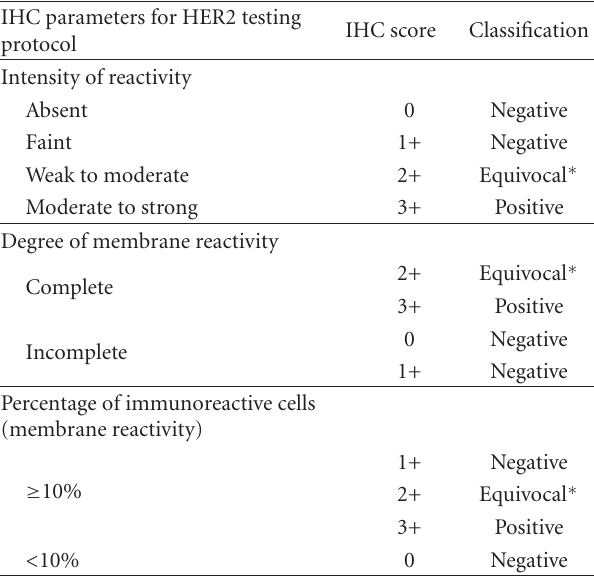
Table 2: HER2 testing by immunohistochemistry in gastric cancer. IHC parameters for HER2